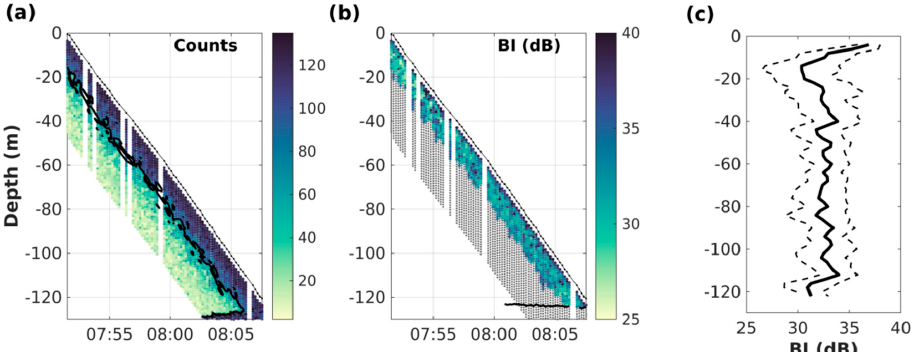
Figure 3. Example of measurements carried out by the Acoustic Doppler Current Profiler (ADCP) during a descent of the glider. ( a ) Swath of the counts signal for each cell of the multiple water profiles. The threshold of 64 counts used to discard erroneous velocity values is shown in black. ( b ) Filtered backscatter index (BI) measurements (dB). Discarded values are shown in gray. A black line shows bottom detection. ( c ) Reconstructed median backscatter index profile and associated standard deviation.